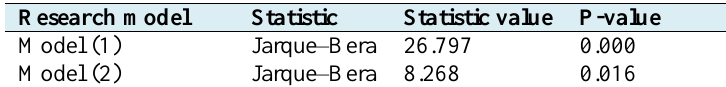
Table 13. The results of the normality of the error term in the